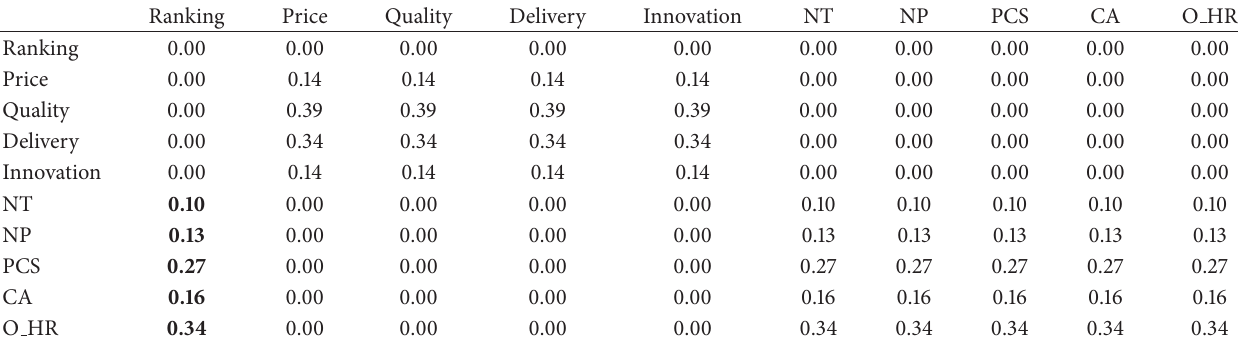
Table 13: Matrix limit corresponding to the decisions of decision agent 4.